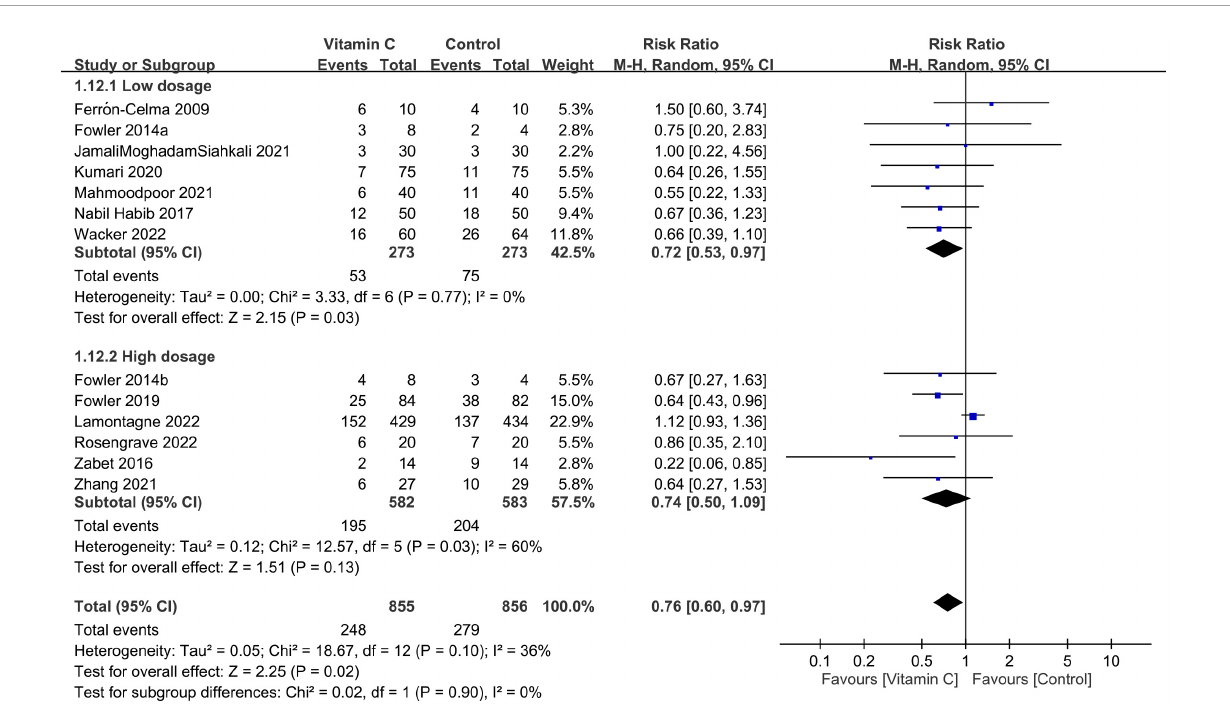
FIGURE5 Subgroup analysis based on vitamin C dosage (cut-off value: 10000 mg/day or 100 mg/kg/day). M-H, Mantel-Haenszel; CI, confidence